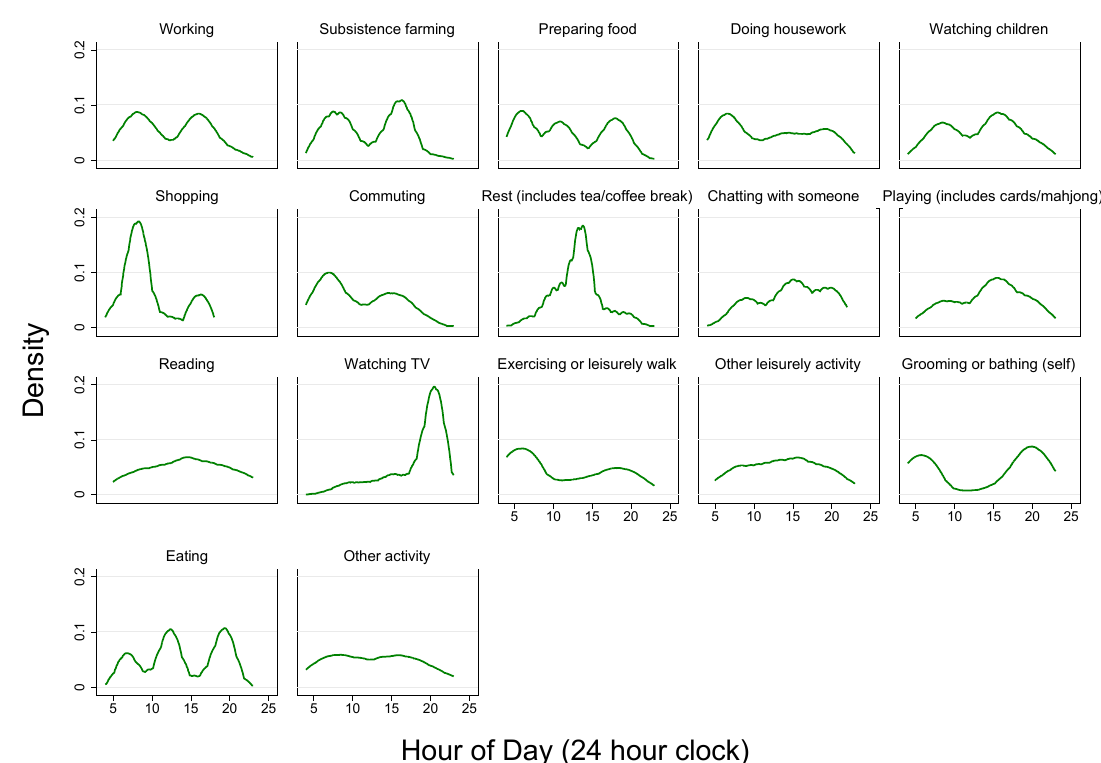
Figure 1. Kernel density plots of time of day by activities.